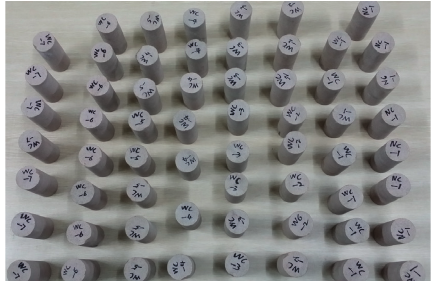
Figure 1: Standard rock samples for test.